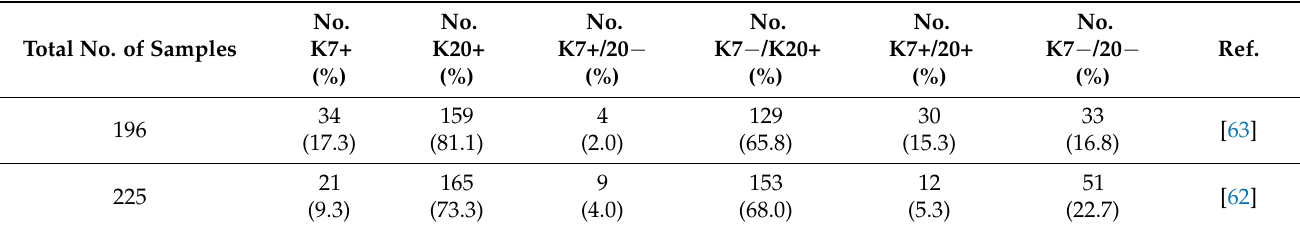
Table 4. Keratin 7 and keratin 20 expression patterns in colorectal carcinoma.